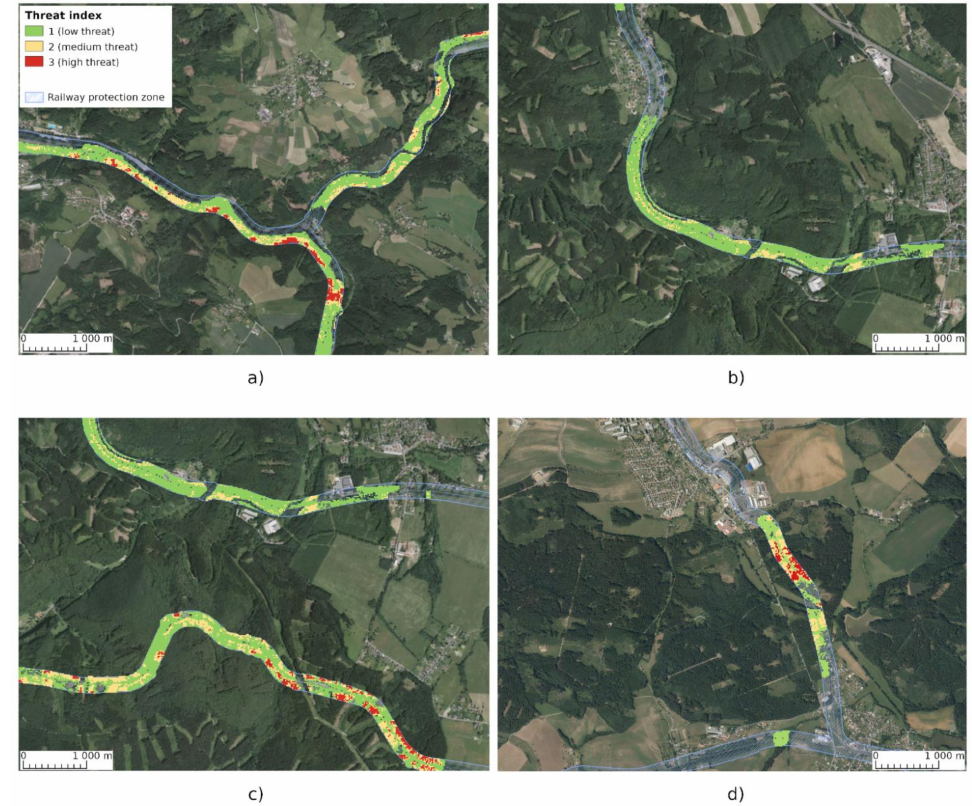
Figure 14. Detailed extracts of four protected areas and their threat indices: ( a ) protected zone with continuous areas of high threat 3 in red; ( b ) protected zone with a prevailing index of 1—low threat in green and minor areas of category 2 in yellow; ( c ) protected zones with many isolated areas of high threat in the southern area and ( d ) protected zone near